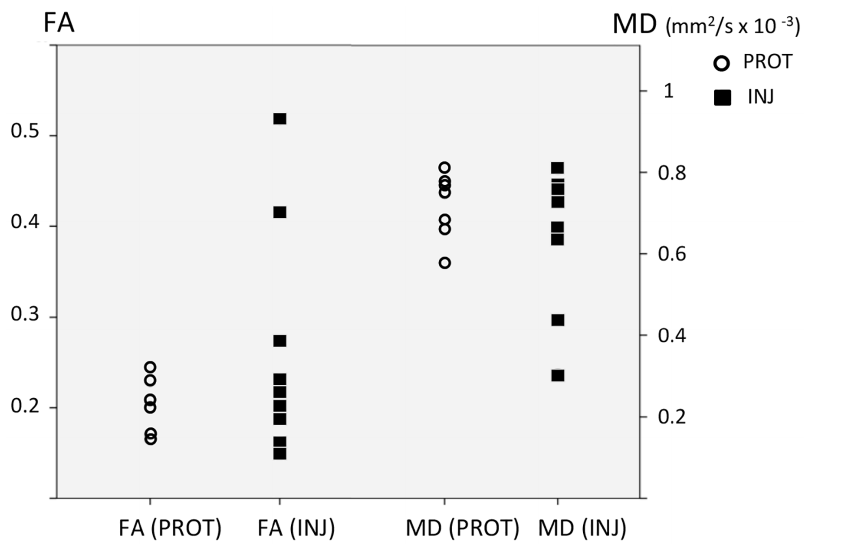
Figure 4. Diffusion measures in the cerebellum. Individual values of fractional anisotropy (FA) and mean diffusitivity (MD) within the cerebellum of protectively ventilated (PROT; open circles) and injuriously ventilated (INJ; black squares) preterm lambs, measured in 30 directions using diffusion tensor imaging. Two of the injuriously venilated lambs had higher FA and lower MD (p , 0.05) in the cerebellum compared to the other lambs.